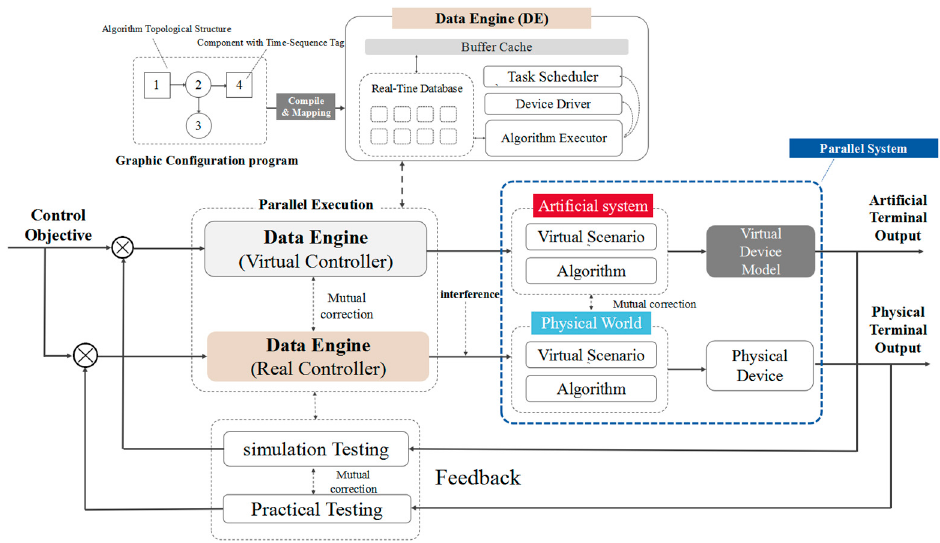
Figure 1. The architecture of PWECS.